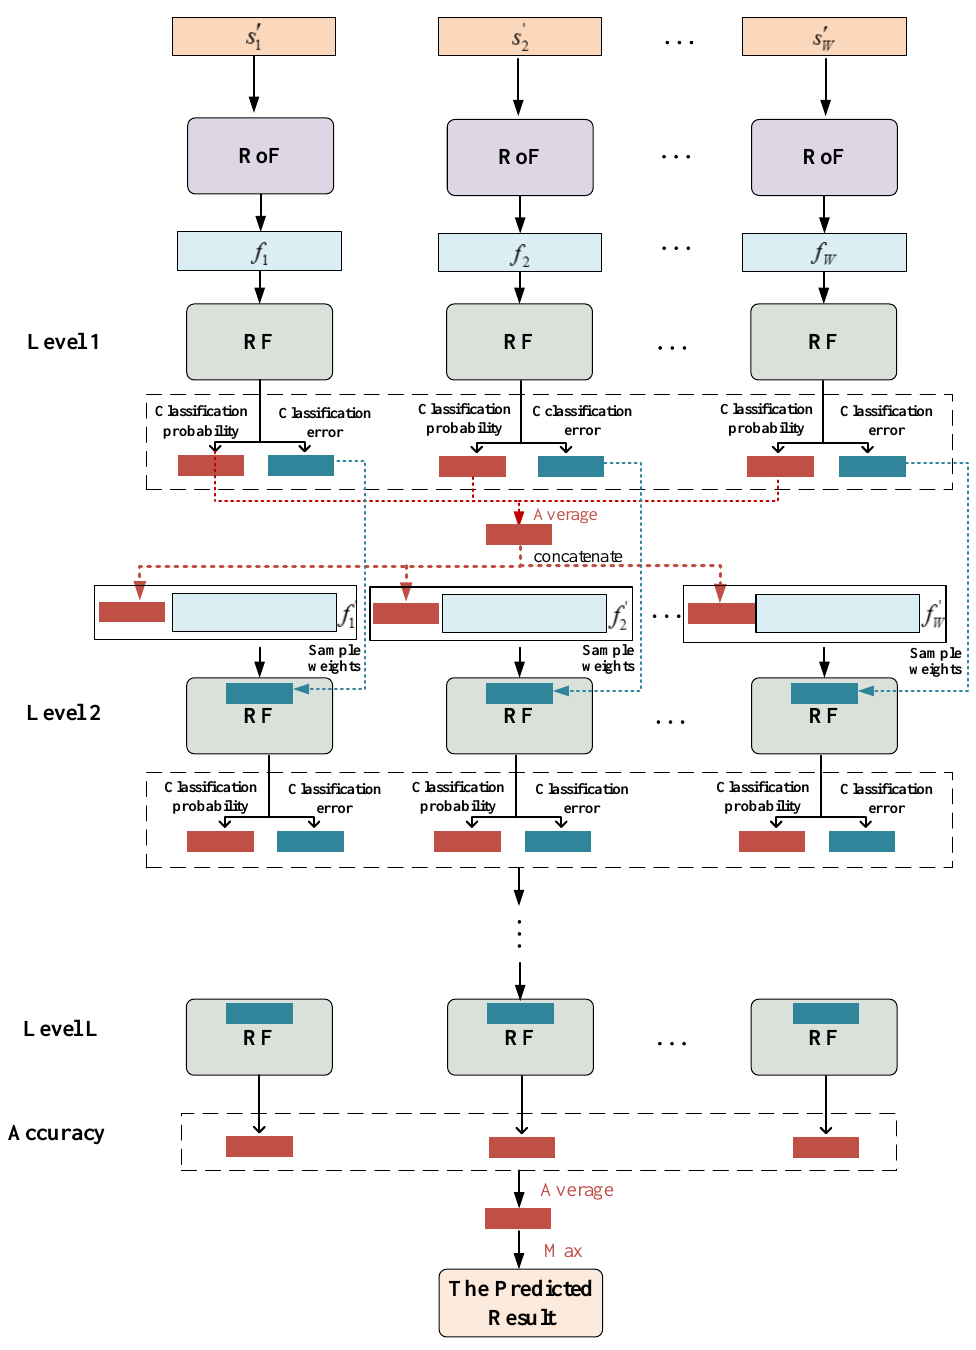
Figure 2. The Flow Chart of